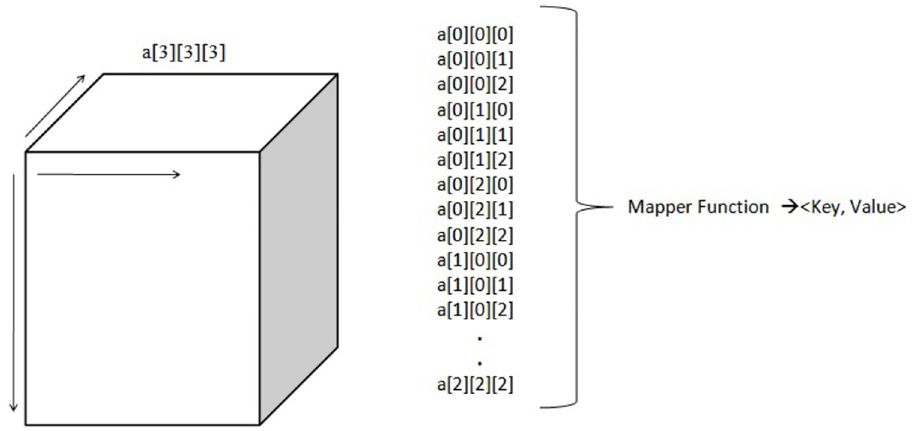
Fig 5. Key and value pairs for a three-dimensional array.